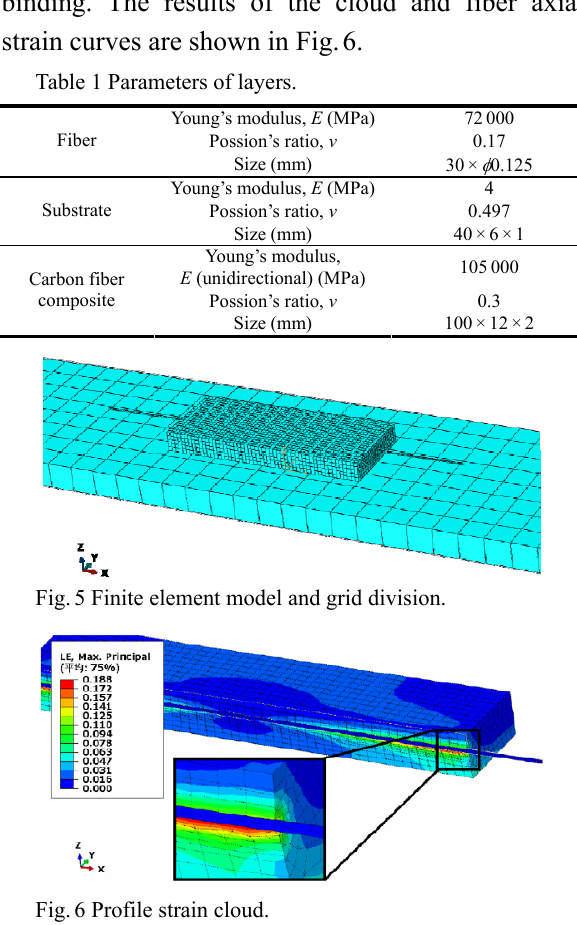
Fig. 6 Profile strain cloud. From the above strain cloud and curve, the input strain of the tensile specimen is 2%, and the maximum strain of the optical fiber is 0.147%, which is less than 0.3% of the long-term use of silica fiber, and the central strain transfer coefficient is 13.6. The average strain transfer coefficient of the embedded part of the optical fiber is 21.3, which indicates that the low modulus elastic substrate can be a good transition of the tensile strain to the small strain of the fiber. As can be seen from Fig. 7, the maximum strain of the substrate occurs at the junction of the two ends with the optical fiber, reaching 18.8%, and the end face is recessed by the fiber, so the fiber debonding is also the first to occur